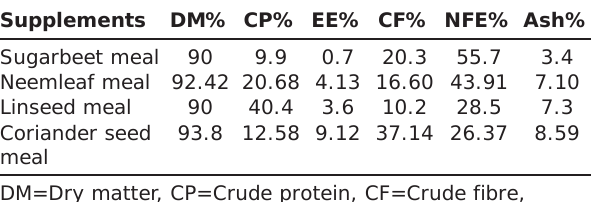
Table-2: Proximate composition of dietary supplements (DM